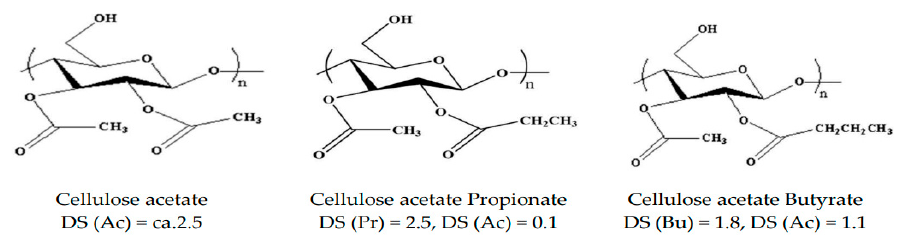
Figure 5. Representative structures of cellulose esters for plastics [21].